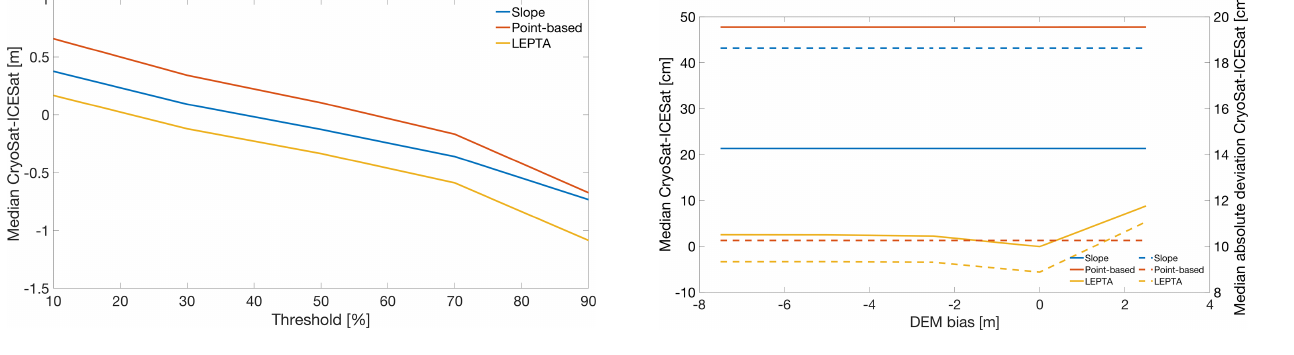
Figure 8. Median (left axis, solid curves) and median absolute de- viation (right axis, dashed curves) of height differences between CryoSat-2 and ICESat-2 ( (cid:49)h calculated with Eq. 16) as a function of a bias in the DEM. Outliers are removed using 10th and 90th